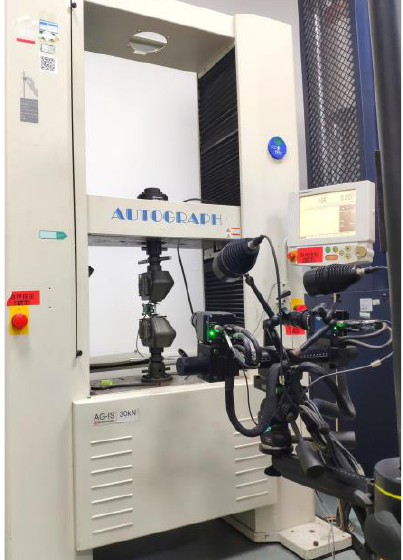
Figure 8. The tensile test of an SF tensile specimen.